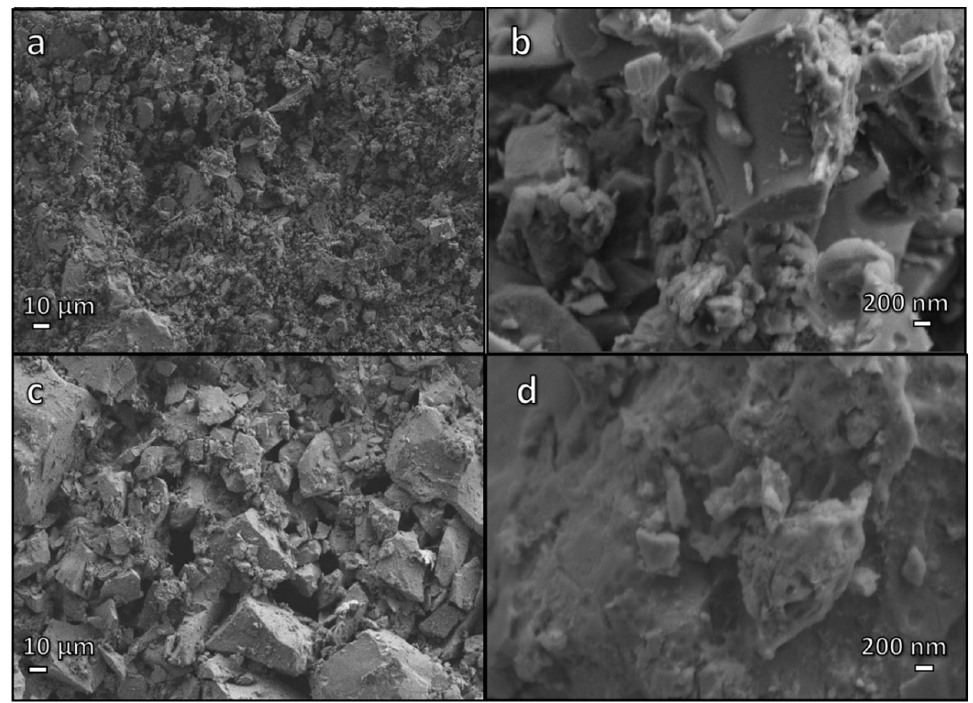
Figure 5. Low and high magnification micrographs of samples after cold consolidation: ( a , b ) simply hardened suspension; ( c , d ) after boiling test.